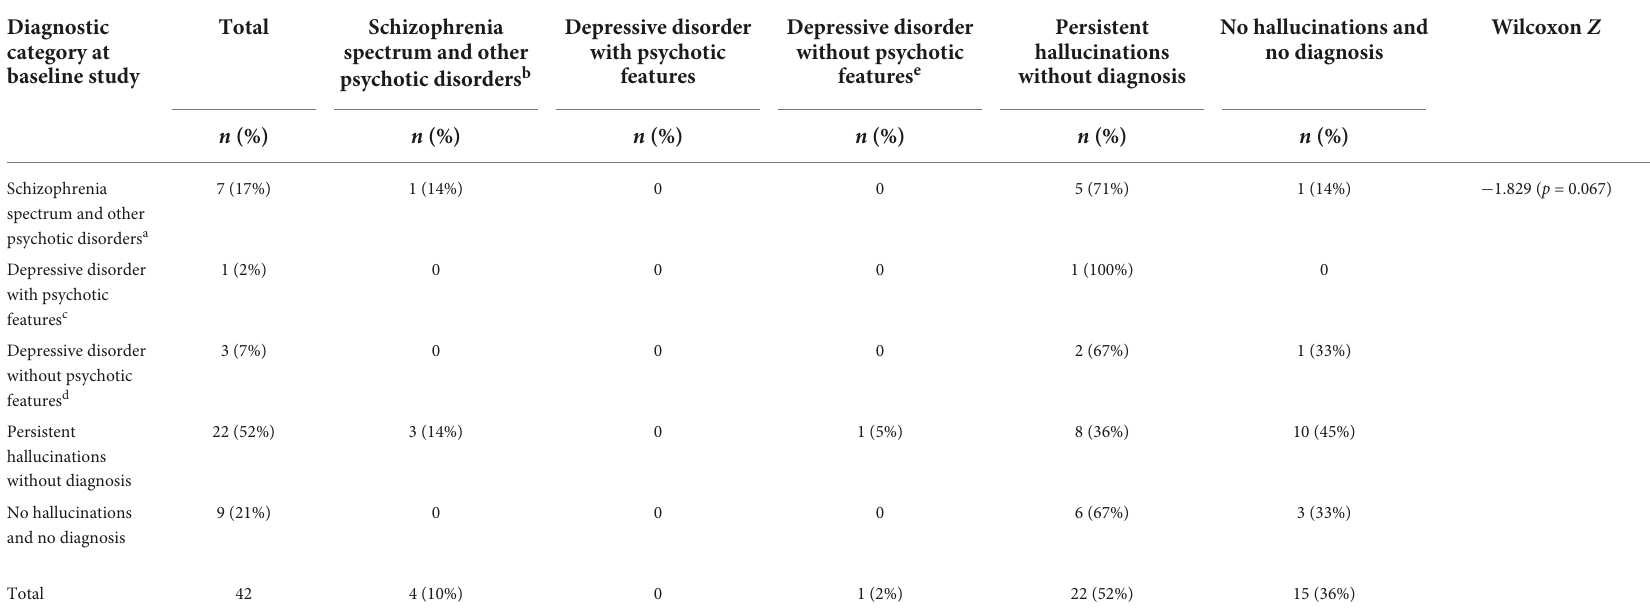
TABLE 3 Stability of diagnostic category across a 39-month